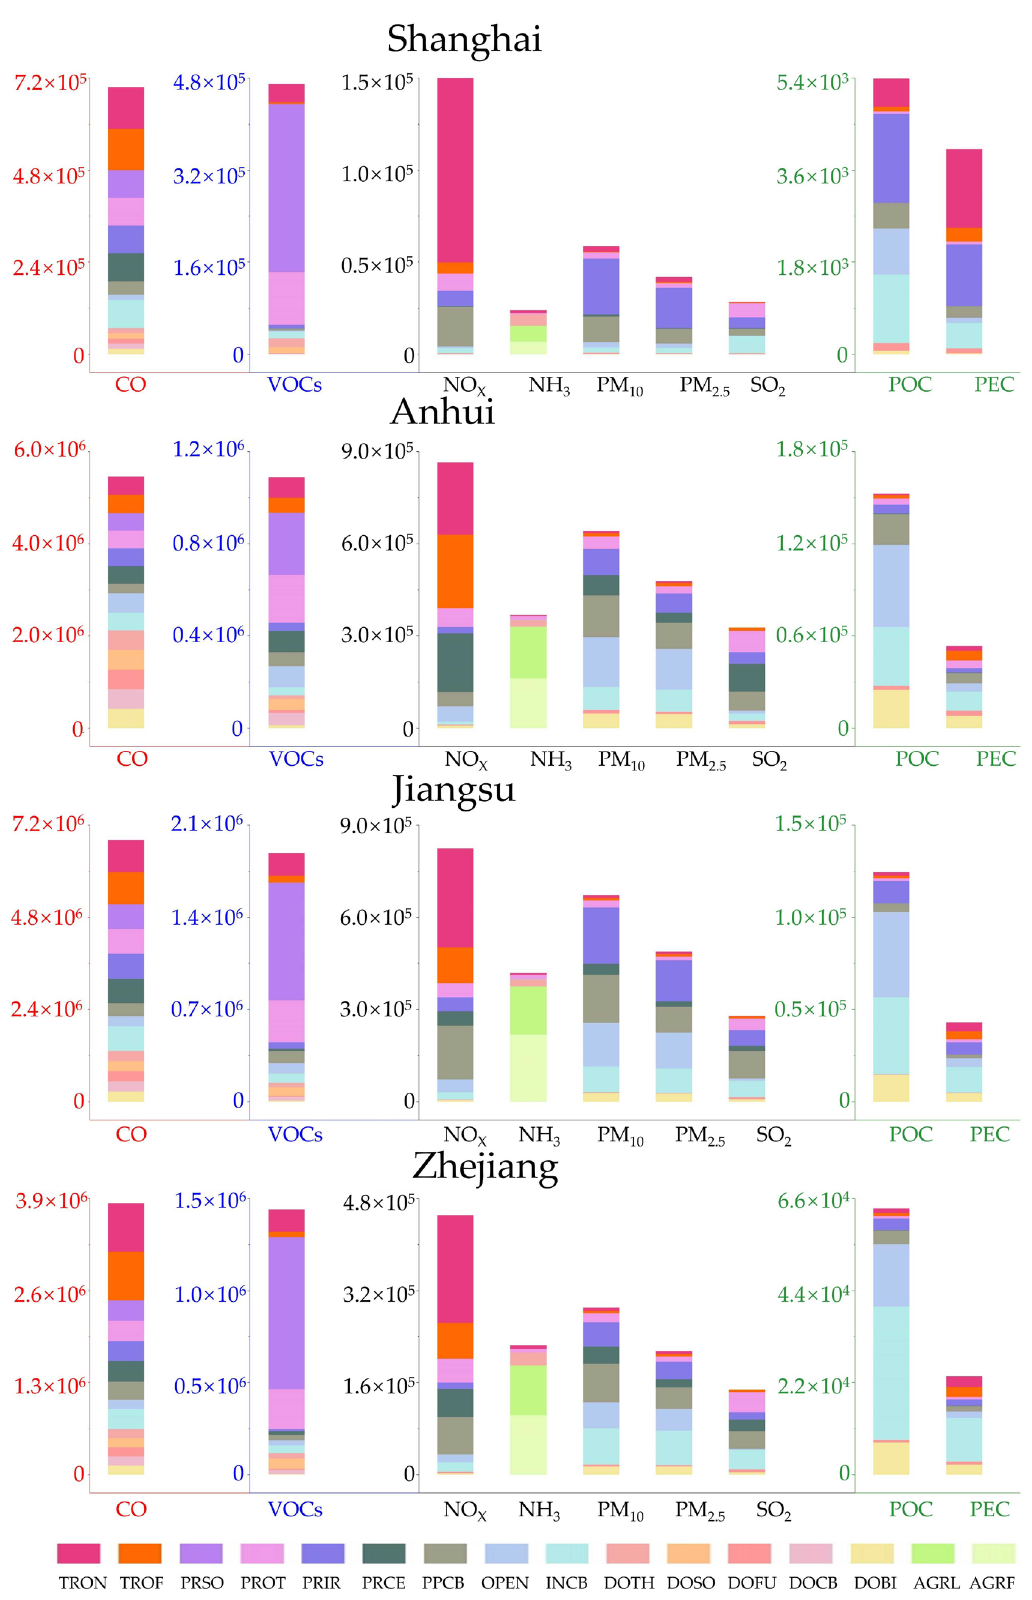
Figure 2. The histogram of 16 sectors of annual emissions in 2018 for each species (CO, VOCs, NOx, NH 3 , PM 10 , PM 2.5 , SO 2 , POC and EC) in Shanghai, Anhui, Jiangsu, and Zhejiang in the YRD. The unit of emission is tons/year (t/a). The descriptions of 16 emission sectors were listed in Table S1.